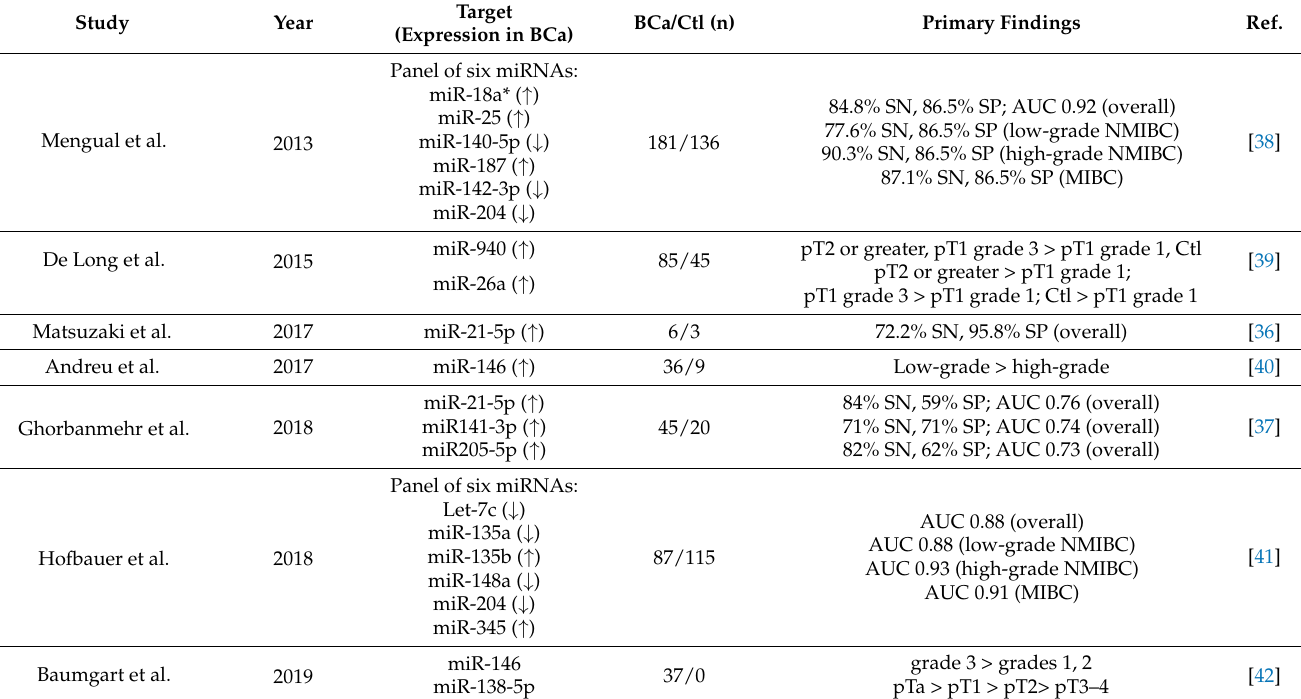
Table 1. Diagnostic accuracy of urinary microRNAs (miRNAs) for bladder cancer (BCa).